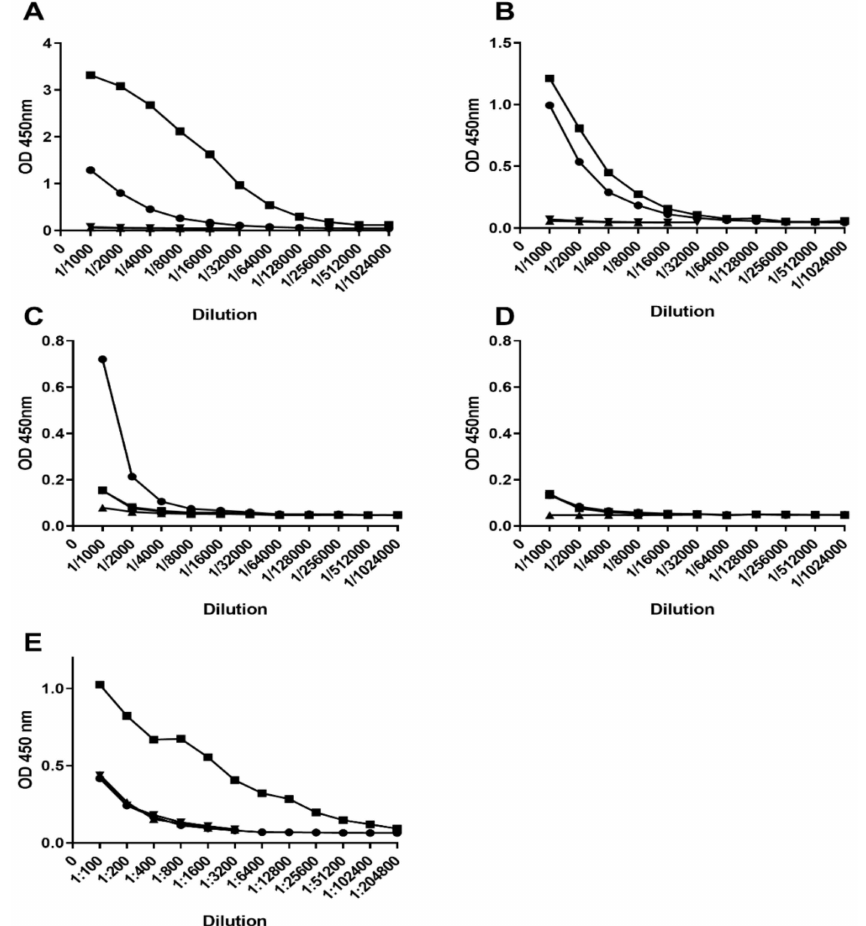
Figure 5. ELISA reactivity of polyclonal rabbit serum raised to KLH-conjugated peptide or KLH-conjugated glycopeptide. Panels ( A , C) coating antigen biotin-SML10 glycopeptide, panels ( B , D ) coating antigen biotin-SML10 peptide, Panel ( E ) coating antigen formalin killed C. di ffi cile R20291 spores. Panel ( A , B , E ) serum IgG response and panels ( C , D ) serum IgA response. Legend: KLH-glycopeptide immune serum titration (black square), (KLH-peptide immune serum titration (circle), KLH-glycopeptide pre-immune serum titration (regular triangle), KLH-peptide pre-immune serum titration (inverted